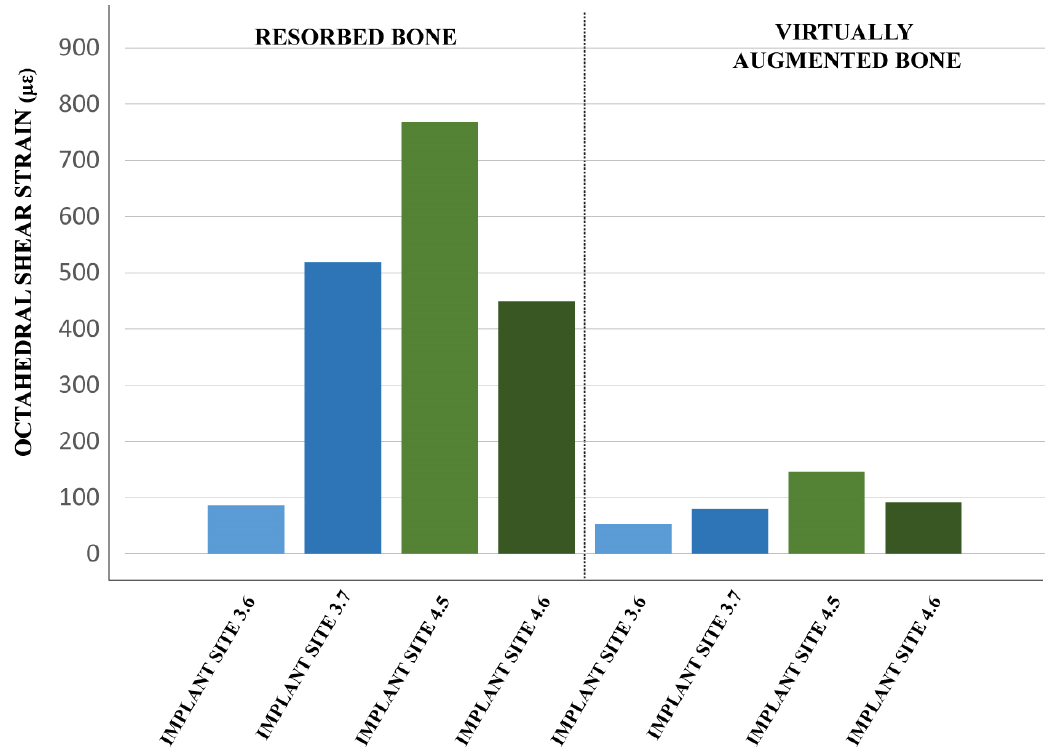
Figure 4. Octahedral shear strain in the resorbed and virtually bone augmented mandible for implant-supported restoration in the third and fourth quadrant.